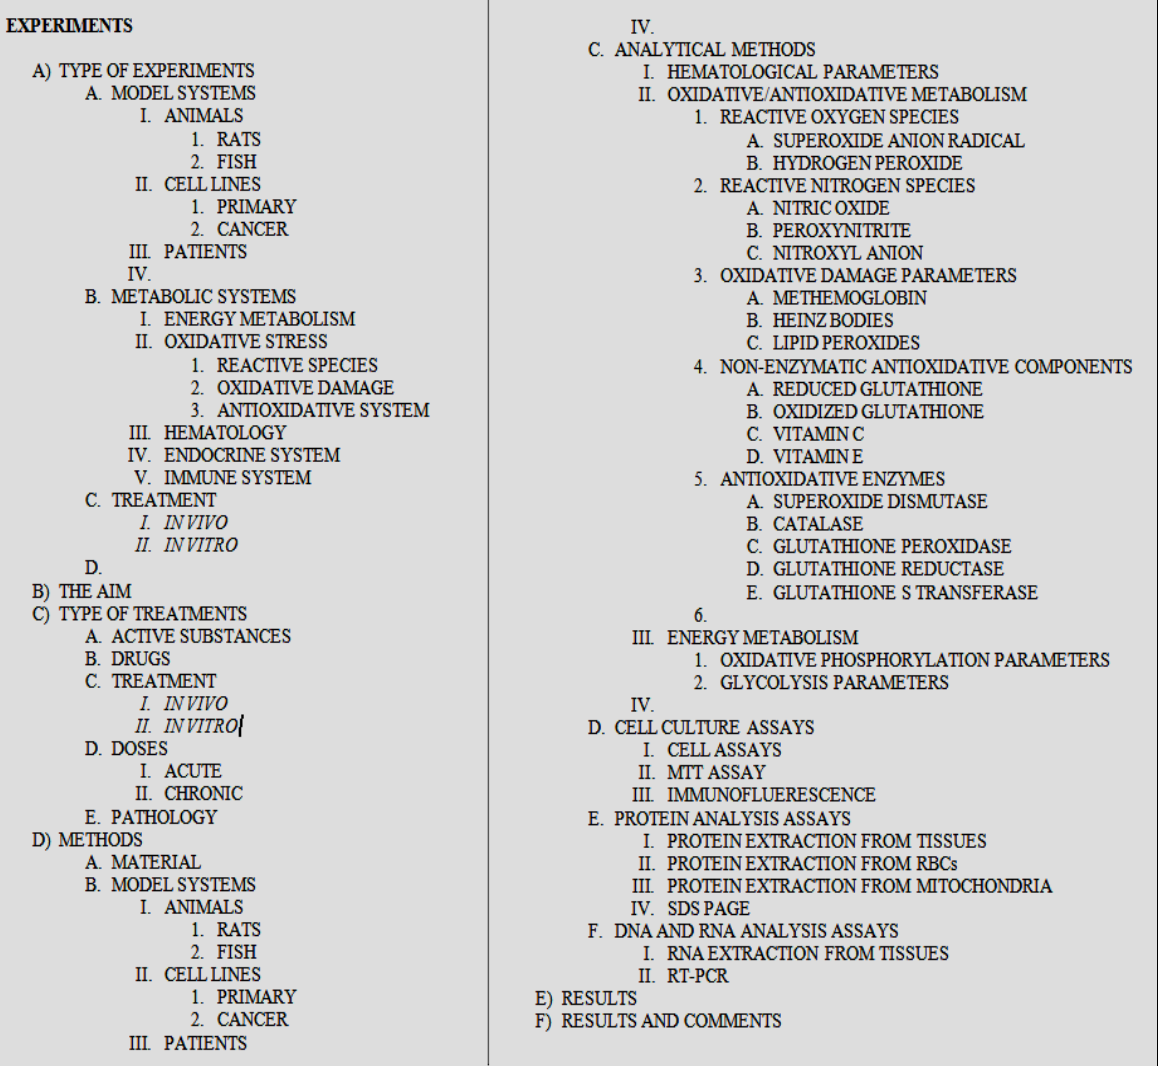
Figure 1. Hierarchical multilevel structure of the